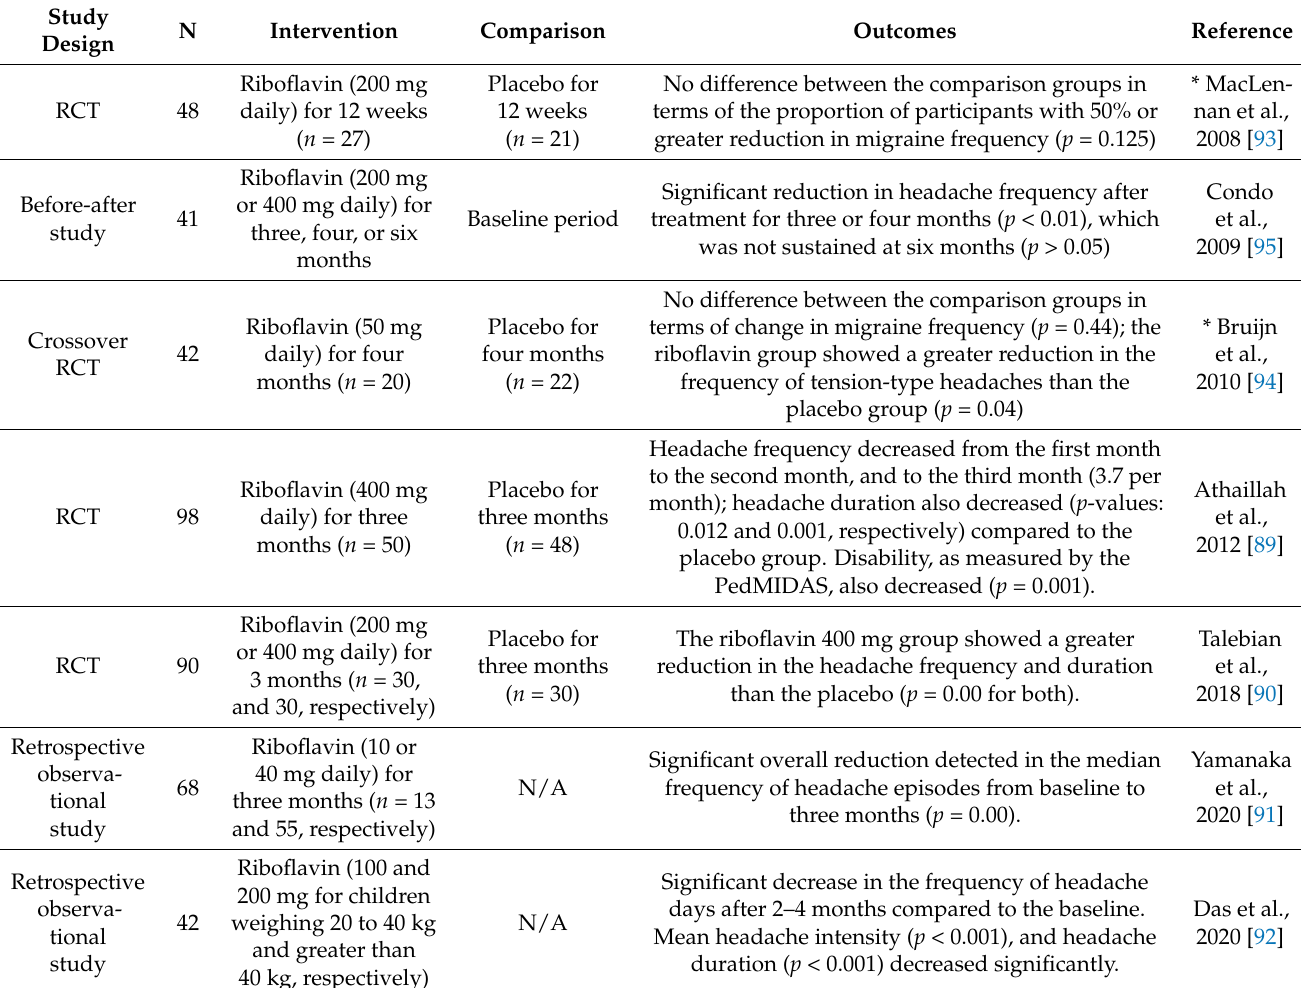
Table 2. Summary of studies on riboflavin for pediatric